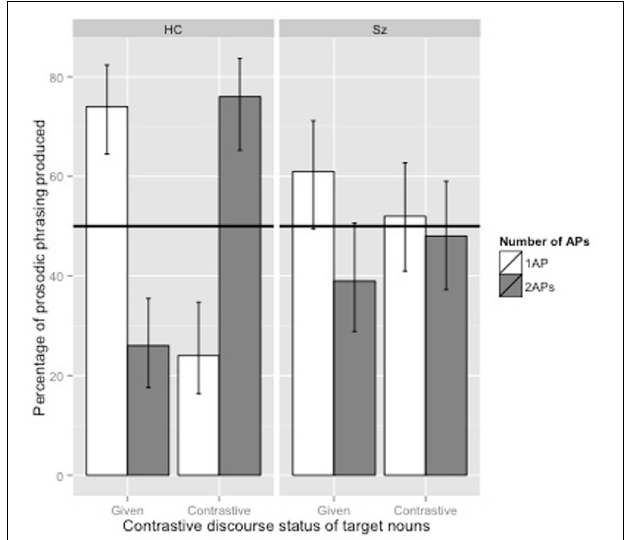
FIGURE 3 | Percentage of prosodic phrasing produced by healthy controls participants (HC) and participants with schizophrenia (SZ) depending on the number of APs they produced (1 AP vs. 2 APs) and the contrastive discourse status of target nouns (given vs. contrastive). Error bars show a default 95% confidence